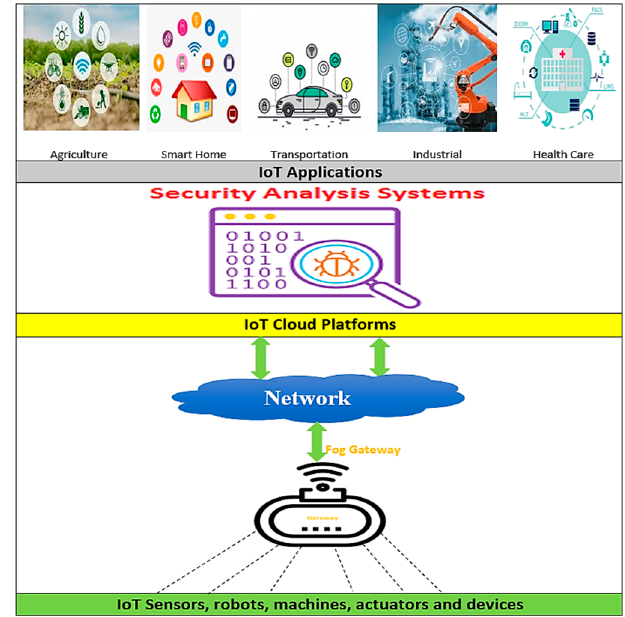
Figure 1. Security analysis systems for IoT applications.